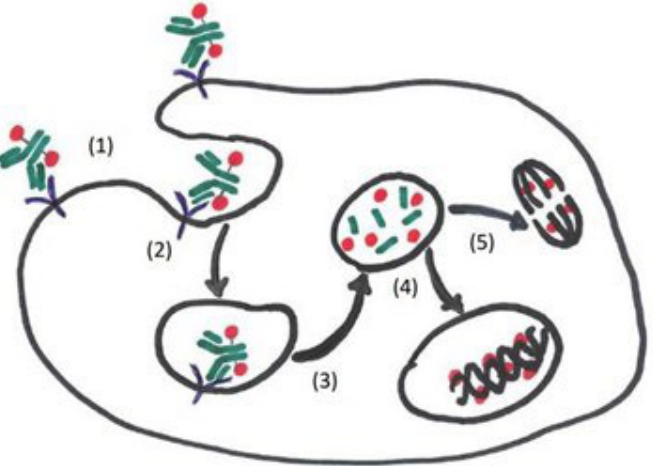
Figure 1. Mechanism of action of ADCs. (1) Circulating ADCs bind to target antigens on the myeloma cell via the monoclonal antibody portion; (2) the ADCs are endocytosed in endosomes; (3) ADCs are then degraded in lysosomes releasing the conjugated cytotoxic payload (toxin, chemotherapy agent, radioisotope, etc.); (4) the cytotoxic payload exerts (deoxyribonucleic acid) DNA damaging effects in the nucleus resulting in cell death; (5) the cytotoxic payload exerts its effects in the cytoplasm via microtubular polymerization and inhibition causing